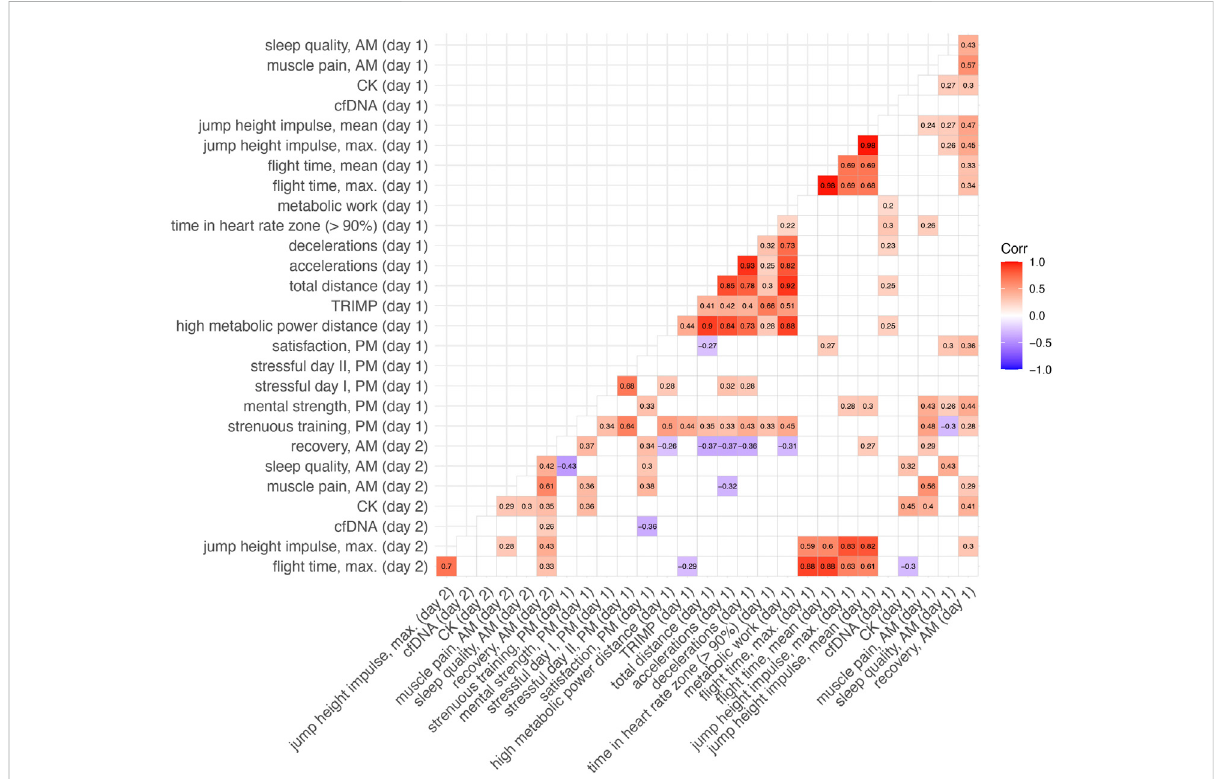
FIGURE 4 Correlation matrix (spearman rank correlation) with selected performance variables, questionnaire data and biomarker concentrations. We hypothesize that questionnaire results (recovery, sleep, muscle pain) and countermovement jump data collected each morning, as well as biomarkers collected in the afternoon, may be in fl uenced by the previous day ’ s training load. Therefore, these seven variables (marked as “ day 2 ” ) were correlated with the training data of the previous day ( “ day 1 ” ). AM = morning, PM = evening, cfDNA = cell-free DNA, CK = creatine kinase, TRIMP = training impulse. Non-signi fi cant correlations are omitted from this fi gure; see Supplementary Material S3 for asummary ofall